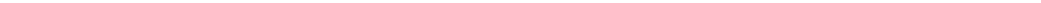
Fig. 2 Notch1 directly activates the Rheb promoter. a q(RT)-PCR of (i, iii) RHEB and (ii, iv) HES1 relative to GAPDH in synchronized (i, ii) 621 – 101 and (iii, iv) CRL4004 angiomyolipoma cells in DMEM. The statistical signi fi cance of RHEB and HES1 expression at different time points was determined relative to time 0. b Expression of Rheb and Hes1 in synchronized (i) 621 – 101 and (ii) CRL4004 angiomyolipoma cells in DMEM by western immunoblotting. Numeric values represent densitometry analysis of the expression of Rheb relative to expression of Gapdh. c (i) Rheb promoter: triangles indicate potential RBPJ binding sites with a reverse (1, 2) and a forward (3, 4) orientation. (ii – v) Binding of Notch1 to (ii, iv) the potential RBPJ binding site 1, NRE2, NRE3, and the potential RBPJ binding site 4 of RHEB or (iii, v) HES1 promoter in non-synchronized (ii, iii) 621 – 101 or (iv, v) CRL4004 cells grown in DMEM by ChIP-qPCR; binding is shown as fold enrichment over the IgG (dotted line). d (i) Wild-type Rheb-luciferase (RHEB), RHEB-RBPJ1- (RBPJ1), RHEB-NRE2- (NRE2), RHEB-NRE3- (NRE3), or RHEB- RBPJ4- (RBPJ4) mutant-luciferase or control-luciferase (control) promoters activity in HeLa cells. (ii) Expression of N1ICD, MAML1, Hes1, Rheb, and phospho-S6K in 293T, HeLa, CRL4004, and H1299 cells. (iii) Expression of cleaved Notch1 (Val1744), Notch1, Hes1, Rheb in 621 – 101, CRL4004, and H1299 cells depleted of Notch1 using shRNA by western blotting or (iv) q(RT)-PCR. Numeric values represent densitometry analysis of the expression of Rheb relative to expression of Gapdh. (iv) NOTCH1 , RHEB , and HES1 relative to GAPDH in 621 – 101 cells depleted of Notch1 using shRNA. e Binding of Notch1 to the (i) potential RBPJ1 site, (ii) NRE2, and (iii) NRE3 within Rheb or (iv) Hes1 promoter in synchronized 621 – 101 cells in DMEM by ChIP-qPCR as in ( c (ii, iii)). Data represent means ± s.e.m. Error bars are de fi ned as means + s.e.m. * P ≤ 0.05, ** P ≤ 0.01, *** P ≤ 0.001, t -test. Data are representative of three ( a (iii, iv), b , d (i – iv)), four ( e ), and six ( a (i, ii), c (ii, iii)) independent